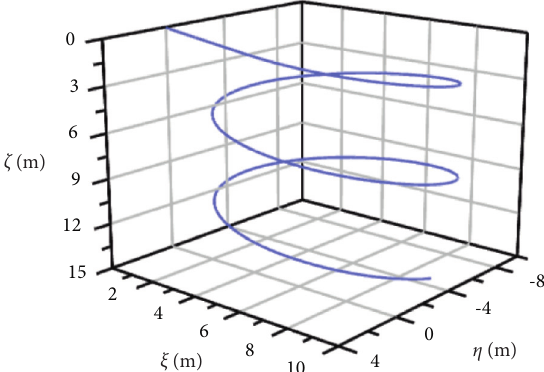
Figure 2: The glider spiral